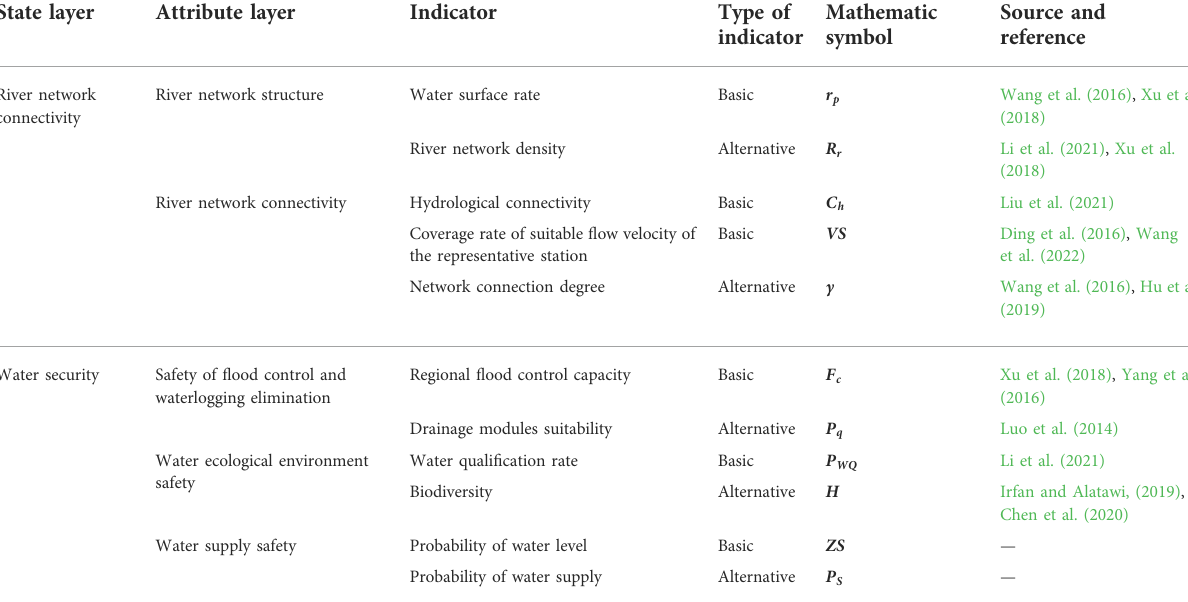
TABLE 1 Index framework to assess the adaptability between river network connectivity and water